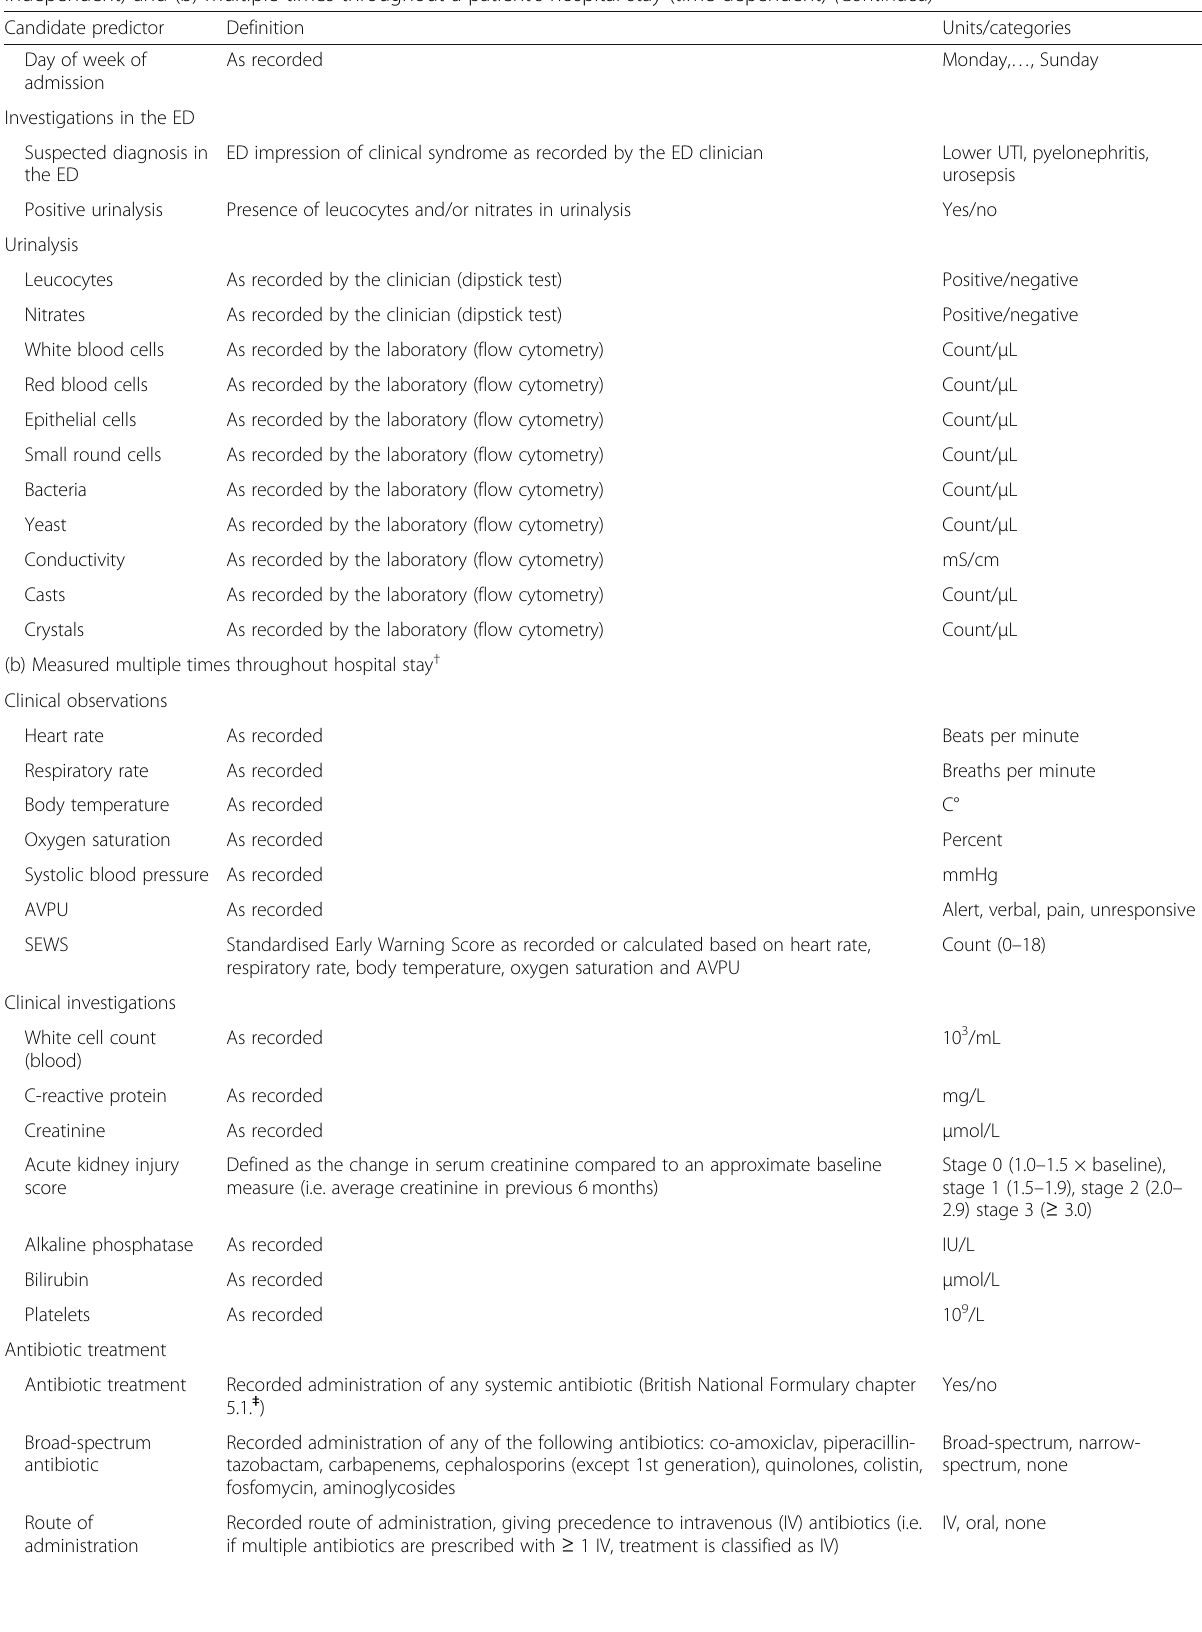
Table 1 Candidate predictors of bacteriuria measured (a) once at admission (constant throughout one hospital stay; time independent) and (b) multiple times throughout a patient ’ s hospital stay (time-dependent)